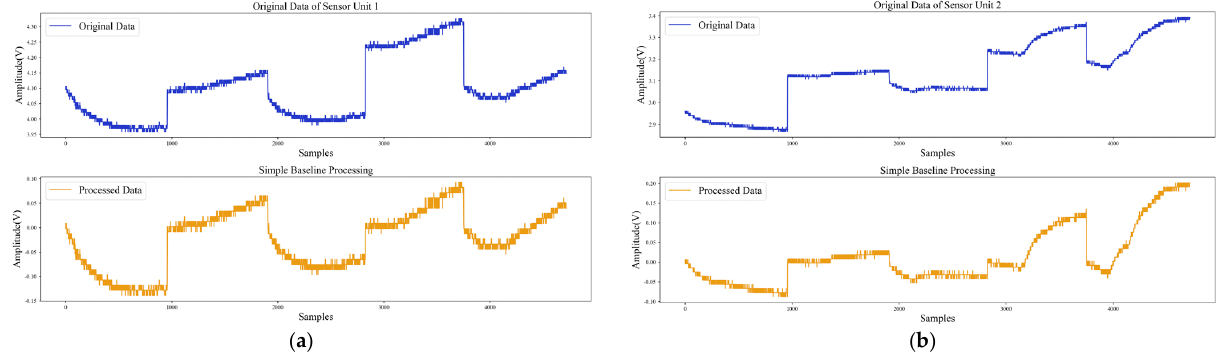
Figure 17. Simple baseline processing: ( a ) Drift compensation for sensor unit 1; ( b ) Drift compensation for sensor unit 2.